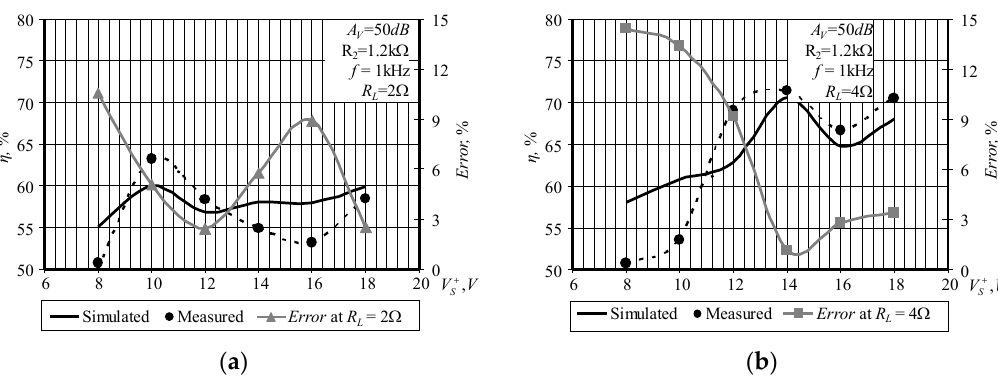
Figure 10. Energy efficiency η versus power supply voltage + V S : ( a ) at a load resistance equal to 2 Ω; ( b ) at a load resistance equal to 4 Ω.